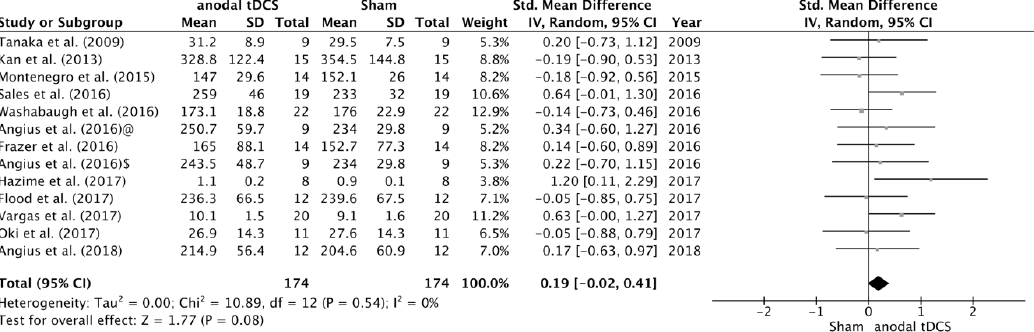
Figure 2. Forest plot of the comparison of MVC between anodal tDCS and sham conditions. Angius